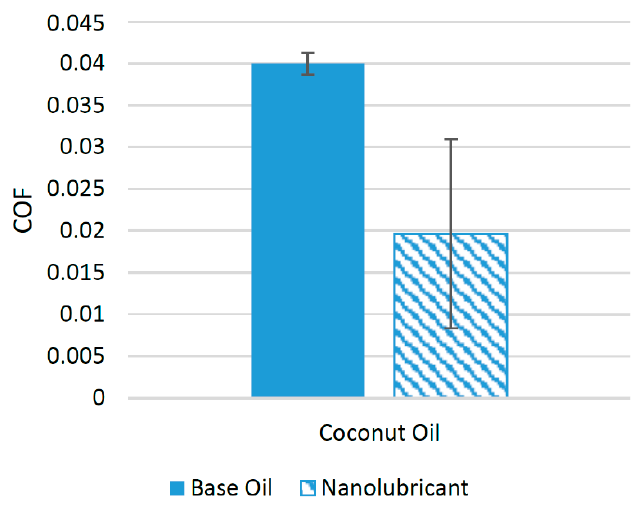
Figure 20. Effect of Silica (SiO 2 ) NPs on the friction performance of bio-lubricants.